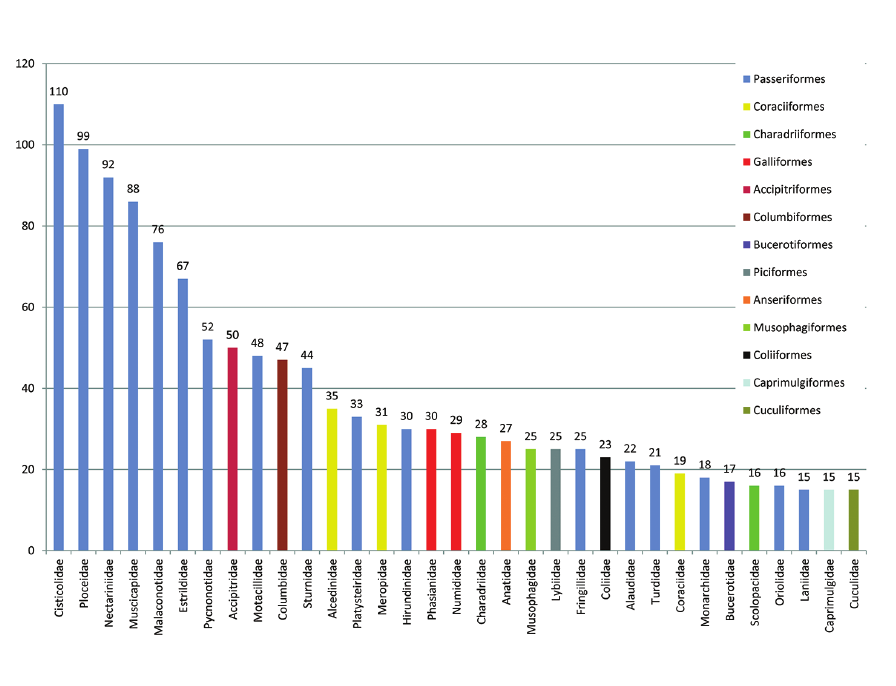
Figure 1. Total number of bird specimens from Mozambique, per family, held in the zoological collec- tions of IICT-ULisboa (Lisbon). The legend lists the corresponding Orders, with assigned colours. Only the categories of families having 15 or more specimens are